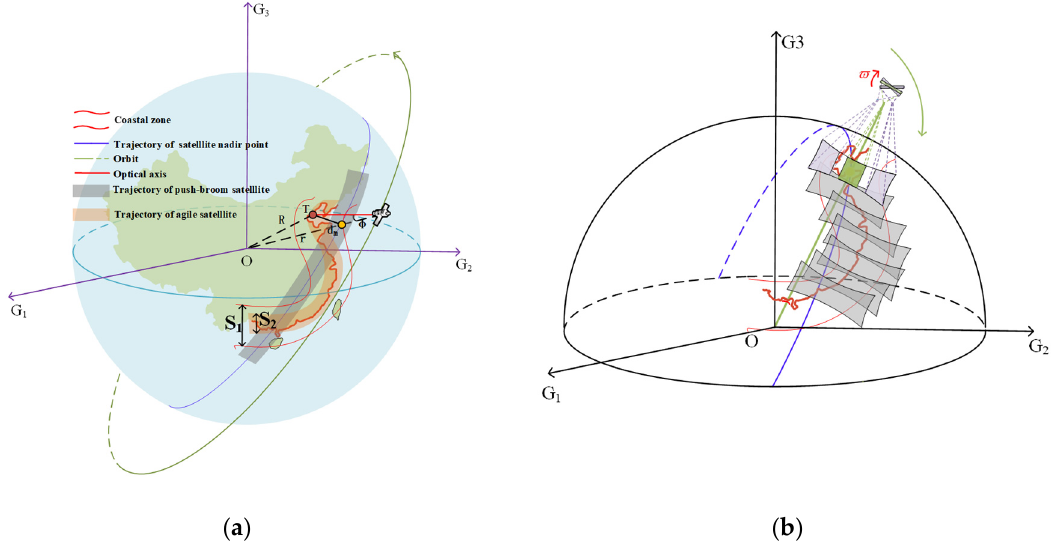
Figure 1. The full coverage technology along the coastal zone: ( a ) Attitude adjustment of the agile satellite along the coastline; ( b ) The swing mirror is used to realize full coverage of the coastal zone based on the agile satellite.